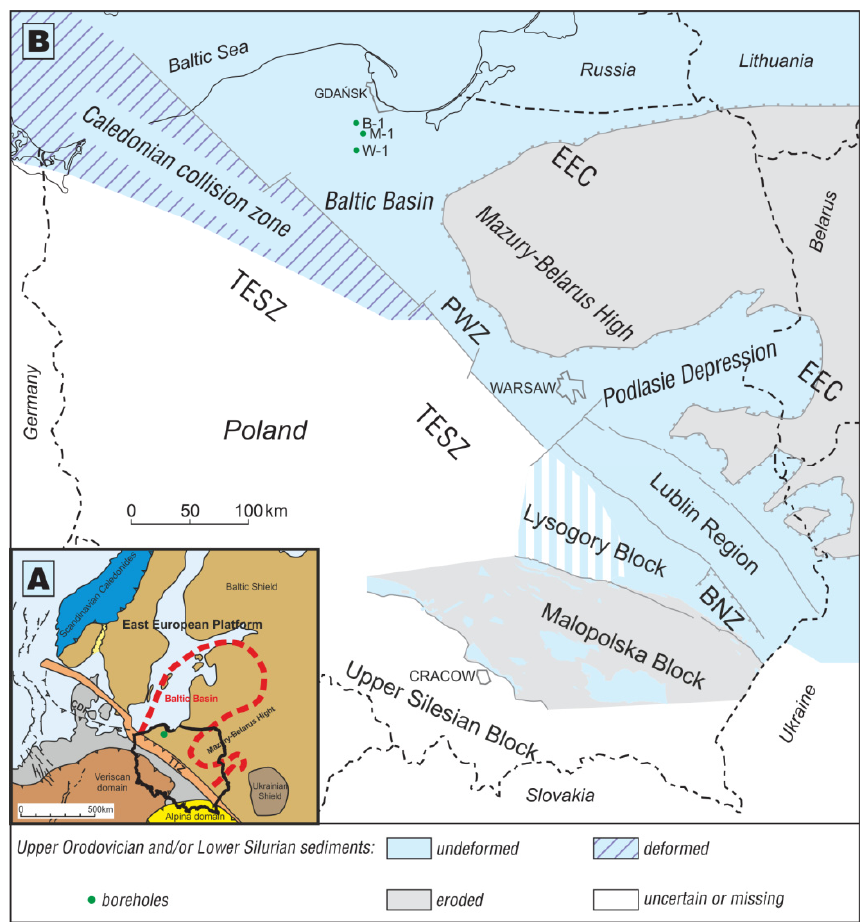
Figure 2. Location of the analysed shale gas boreholes (green dots) with regard to ( A ) lower Paleozoic Baltic Basin (CDF—Caledonian Deformation Front, TTZ—Teisseyre-Tornquist Zone [26,33]) and ( B ) lower Paleozoic sedimentary basins and area covered by Upper Ordovician and lower Silurian shales (PWZ—Płock-Warsaw Zone, BNZ—Biłgoraj-Narol Zone, EEC—East European Craton, TESZ—Trans-European Suture Zone [25,33]).